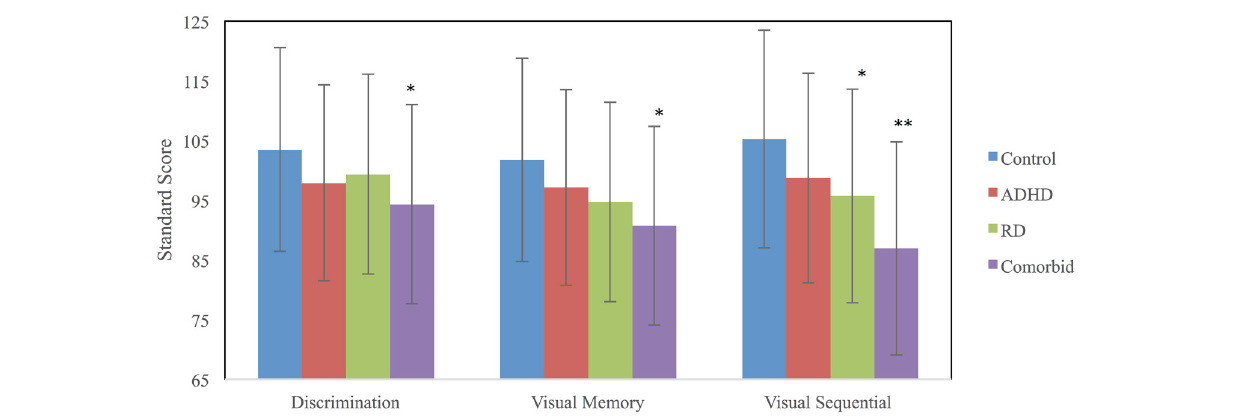
FIGURE 1 | TVPS-R marginal means for each group adjusted for the covariate, Verbal Comprehension Index (VCI). Error bars were derived using SD. * Significantly different from the control group. **Significantly different from both the ADHD and control groups.